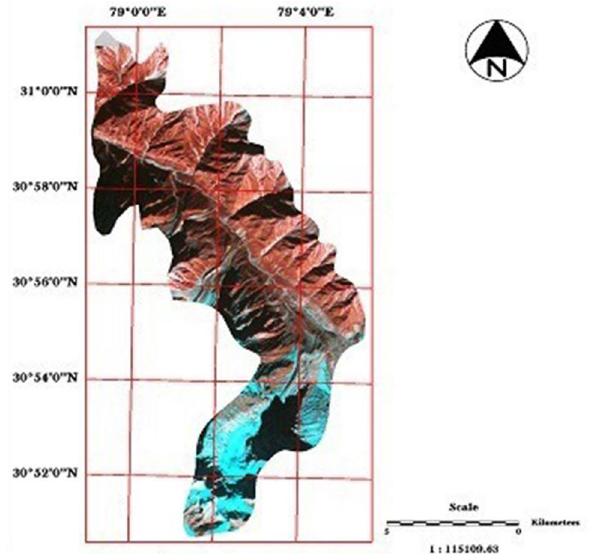
Fig. 5 Digital terrain model (DTM) of the Gangotri glacier